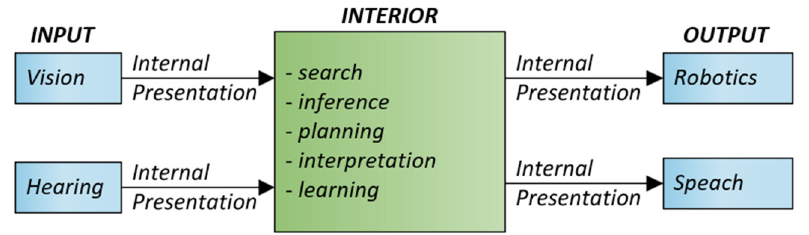
Figure 12. Universal Intelligent System or Arti fi cial Human